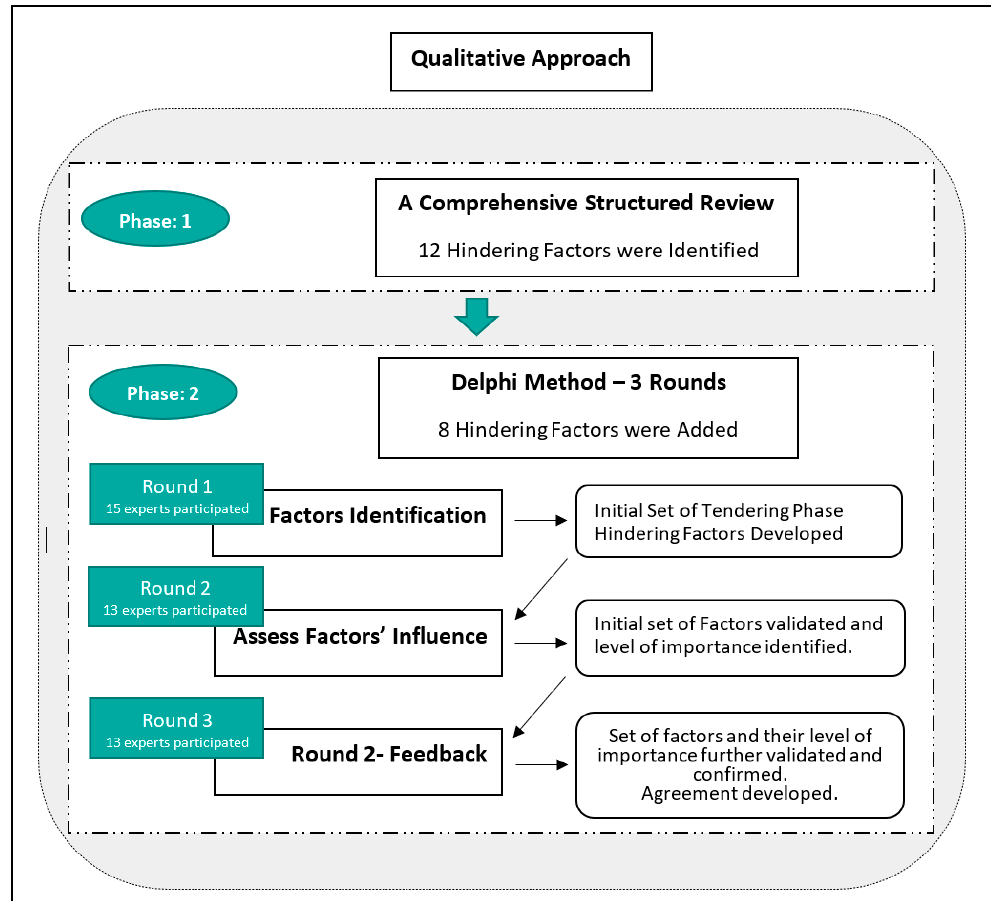
Figure 1. Research Design.2.1. Literature Review.